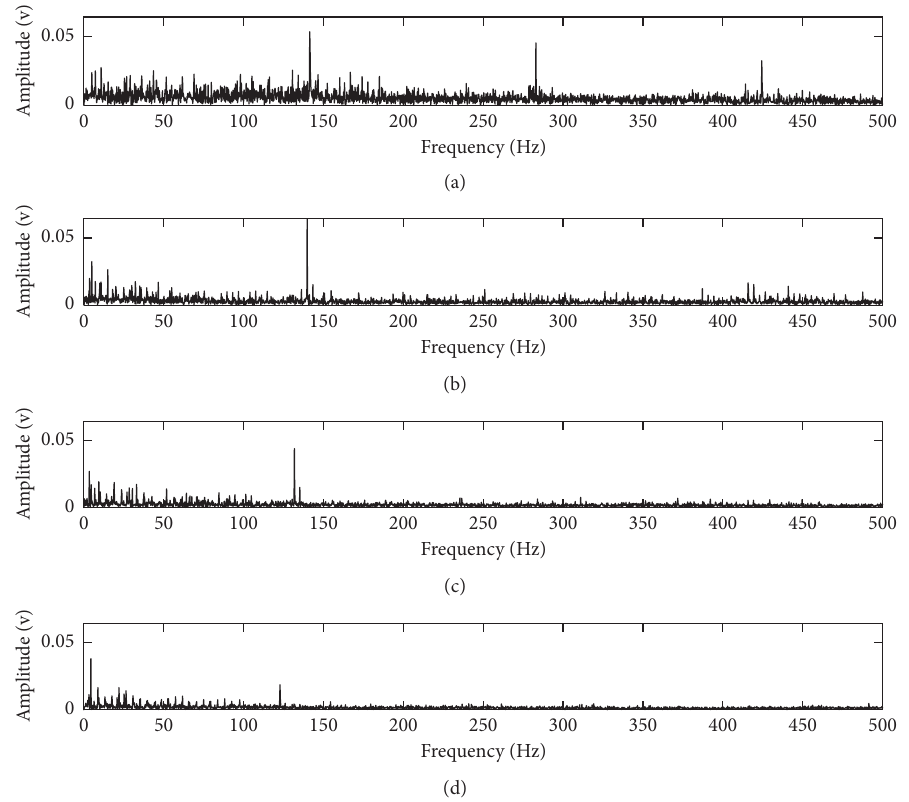
Figure 21: The envelope demodulation spectral analysis results of the signals as shown in Figure 20.